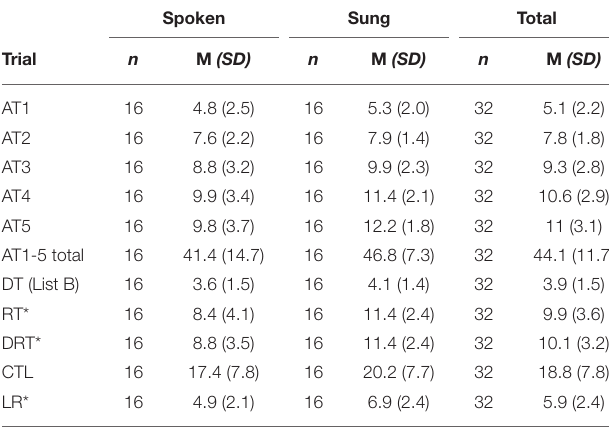
TABLE 2 | Mean recall and composite scores by group for all